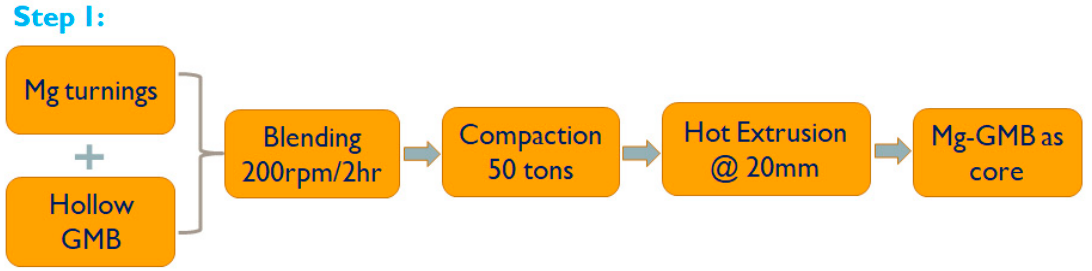
Figure 1. Schematic representation of the processing of core (Mg-20GMB) material.